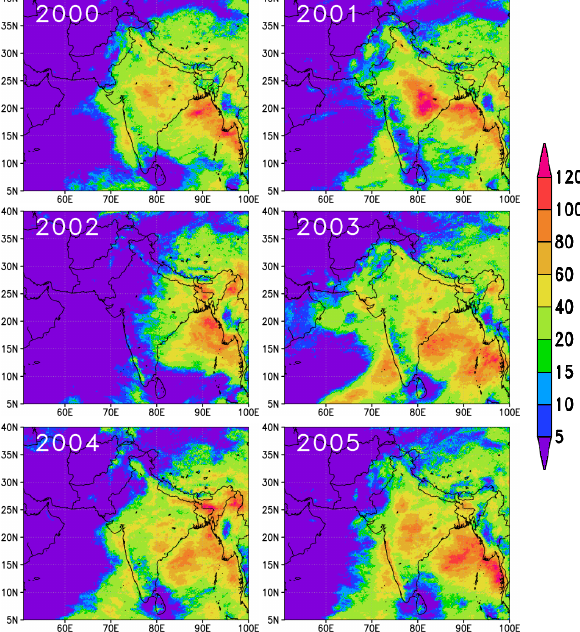
Figure 11. Frequency of occurrence of convection per month for each July between 2000 and